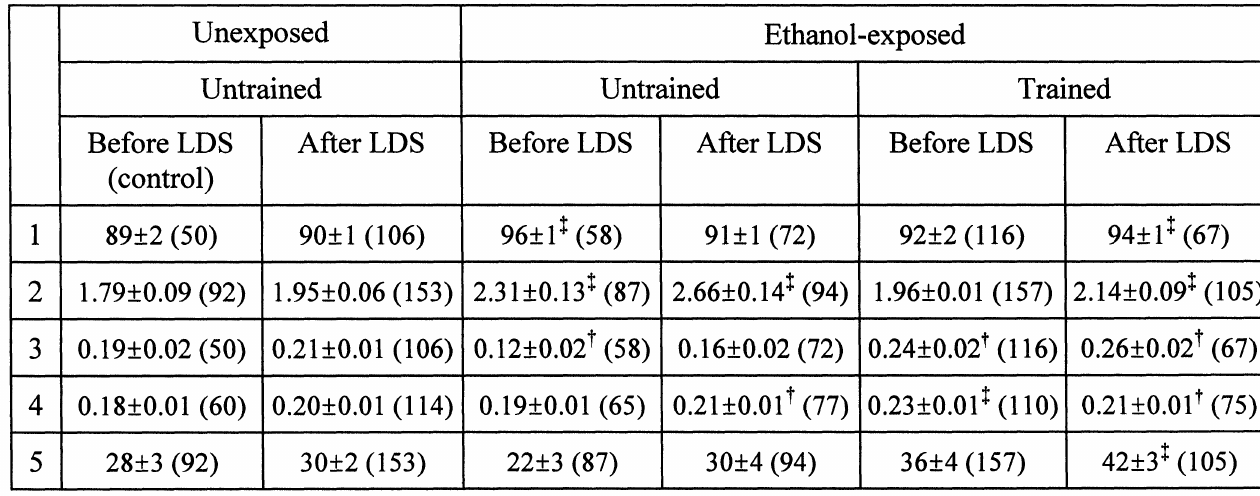
Effect of training, ethanol exposure, and LDS on the afferent synaptic endings of goldfish